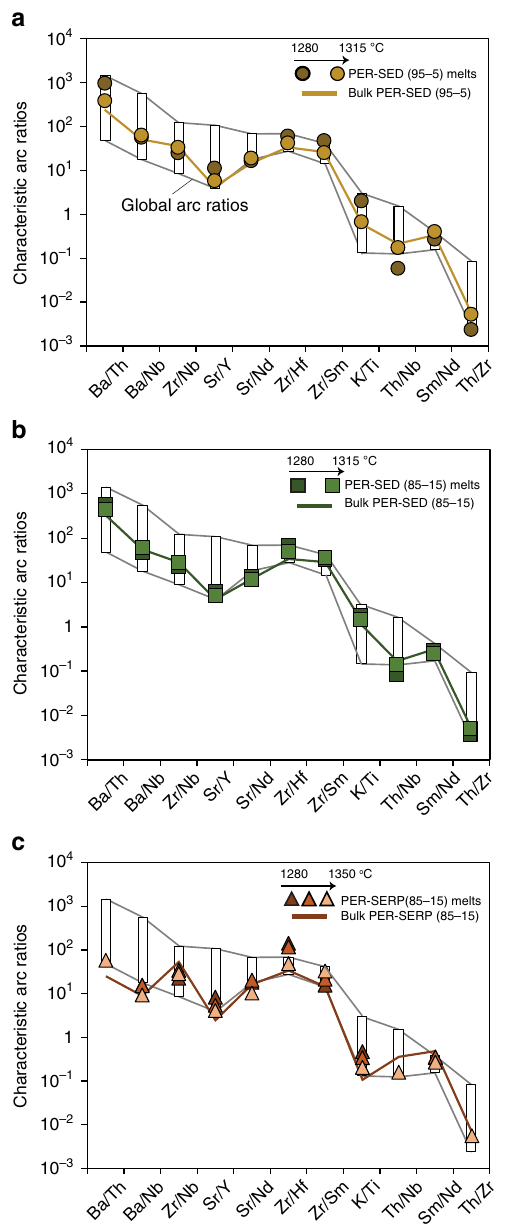
Fig. 7 Trace element ratios of experimental melts compared to natural arc magmas. Trace element fractionations of experimental peridotite-mélange melts ( a – c ) compared to the bulk starting compositions (yellow, green, and red lines) and global arc ratios de fi ned by Turner and Langmuir database 35 (white